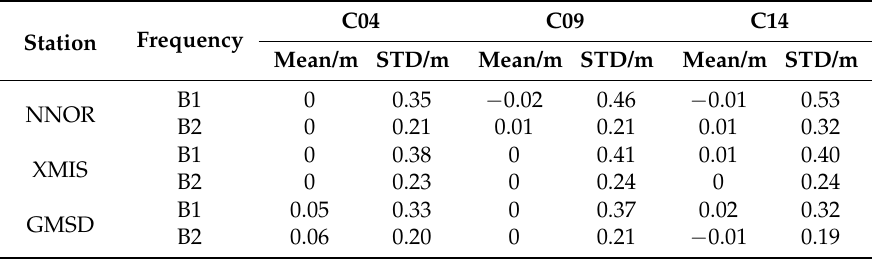
Table 2. Statistical results of the SIS UREs (m) after eliminating the trend term covering 14 experimental days.